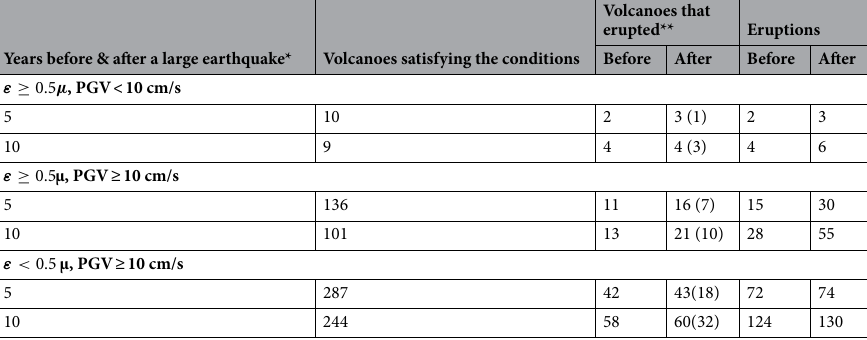
Table 1. Number of eruptions and volcanoes that erupted. *10 years: CMT 1976–2010. 5 years: CMT 1976–2015. **Numbers in parentheses represent the number of volcanoes that erupted both before and after large